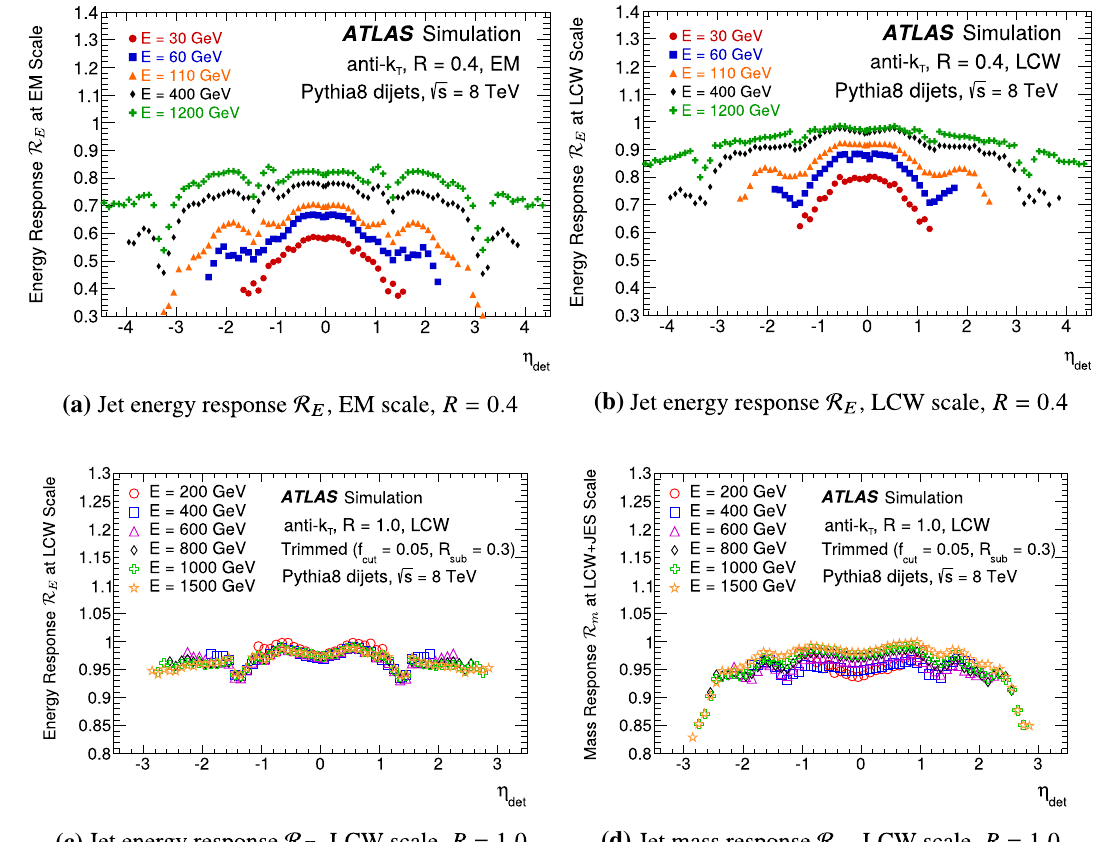
Fig. 4 Jet energy and mass responses as a function of η det for different truth-particle jet energies. The energy responses R E for anti- k t jets with R = 0 . 4 at the a EM scale and the b LCW scale and c for trimmed anti- k t R = 1 . 0 jets are presented. Also, d the jet mass response R m for